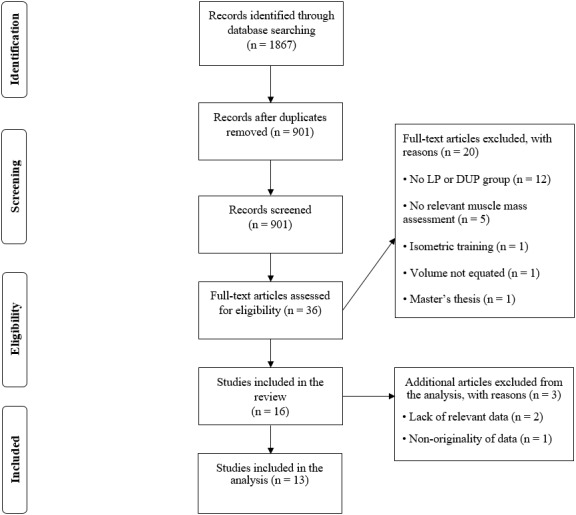
Flow diagram of the search and study selection process.